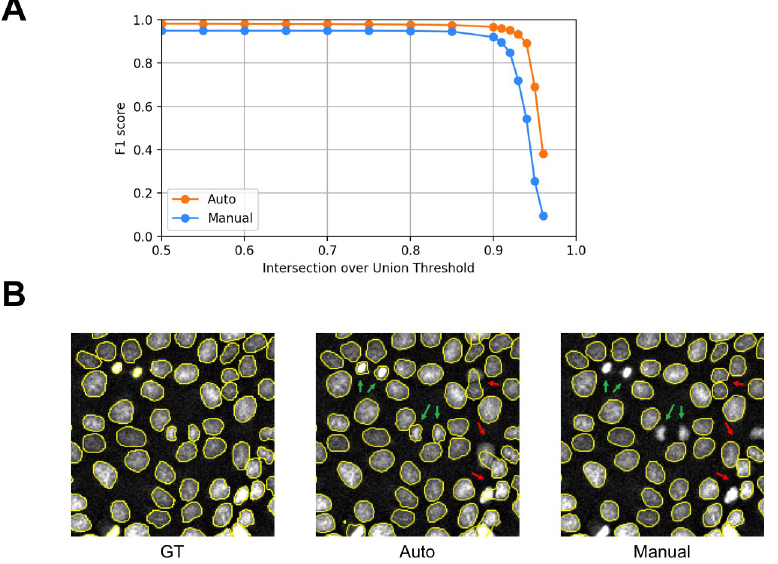
Fig 4. Nuclei segmentation performance of a neural network trained on an automatically and manually annotated training dataset. A: Average F1 score compared to intersection over union of a segmented microscopy dataset trained on automatically and manually annotated nuclei. The average F1 score measures the proportion of correctly segmented objects considering True Positives, False Positives and False Negatives. The intersection over union (IoU) thresholds determine the segmentation accuracy of the neural network (trained on automatically and manually annotated data) compared to the ground truth. High thresholds indicate a strict boundary matching. Average F1 scores remain nearly constant up to IoU = 0.90. At even higher thresholds, accuracy decreases sharply. B: Regions of interest of nuclei segmentation. Ground truth nuclei data are compared to segmentation of a neural network trained on an automatically and manually annotated dataset. Segmentation differences are indicated with green and red arrows. A neural network trained on automatically annotated nuclei provides higher segmentation precision of small nuclei (green arrows). A neural network trained on manually annotated nuclei provides higher accuracy segmenting touching nuclei (red arrows).